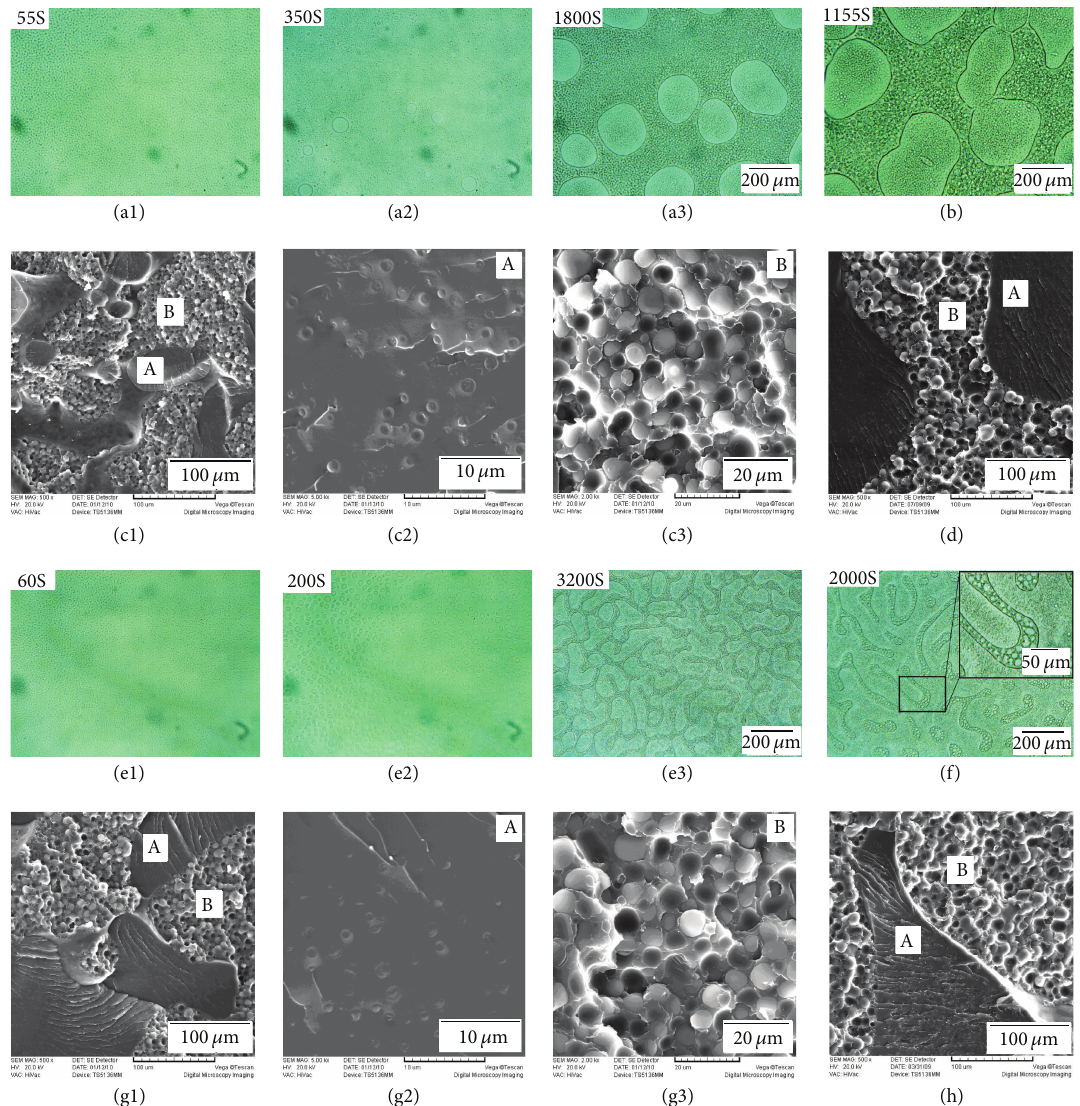
Figure 2: Development of morphologies of the blends followed by OM and SEM micrographs of the fracture surface of the blends. (a1)–(a3) PES-14.3 by OM at 120 ∘ C; (b) finial morphology of PES-14.3 by OM at 140 ∘ C; (c1)–(c3) PES-14.3 by SEM at 120 ∘ C for 5h; (d) PES-14.3 by SEM at 140 ∘ C for 5 h; (e1)–(e3) PES-11.4 by OM at 120 ∘ C; (f) finial morphology of PES-11.4 by OM at 140 ∘ C; (g1)–(g3) PES-11.4 by SEM at 120 ∘ C for 5h; (h) PES-11.4 by SEM at 140 ∘ C for